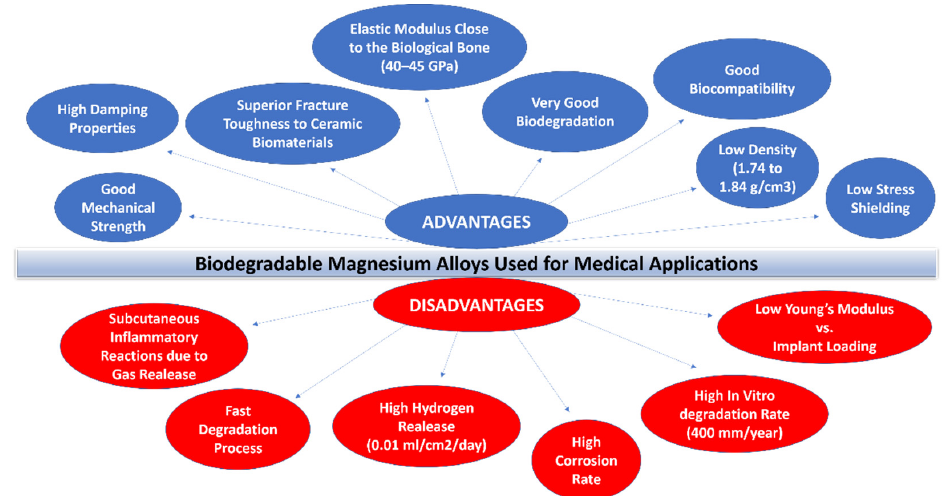
Figure 1. Main aspects of biodegradable magnesium alloys used in the medical domain [10].